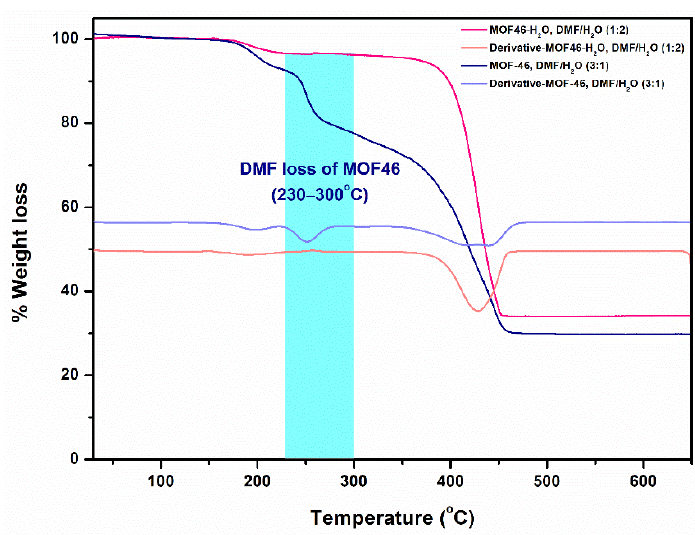
Figure 13. TGA curves of MOF-46(Zn) and MOF-46(Zn)-H 2 O.